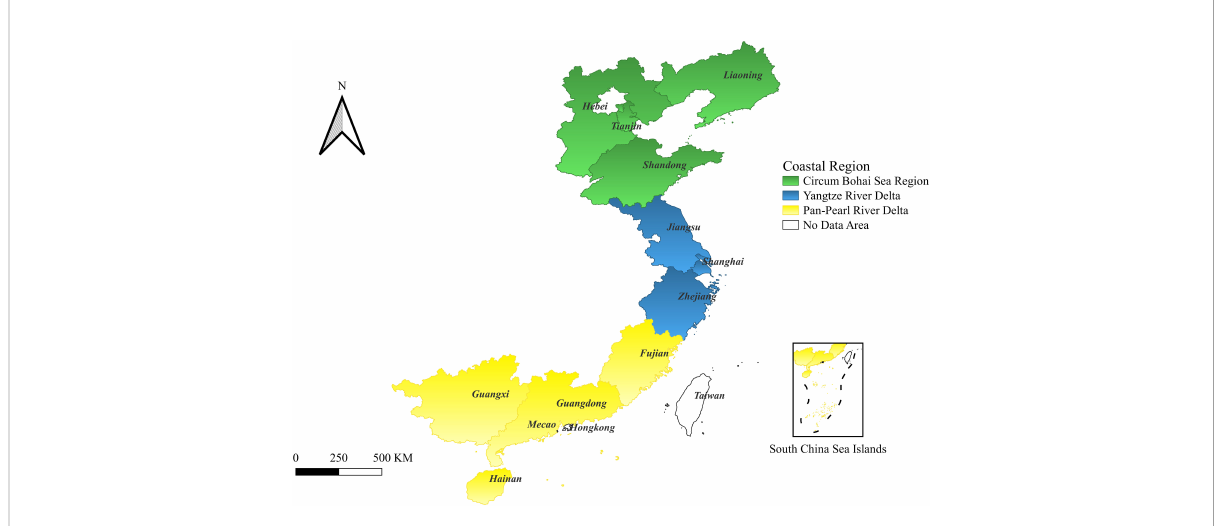
FIGURE 1 The overview and classi fi cation of China ’ s coastal